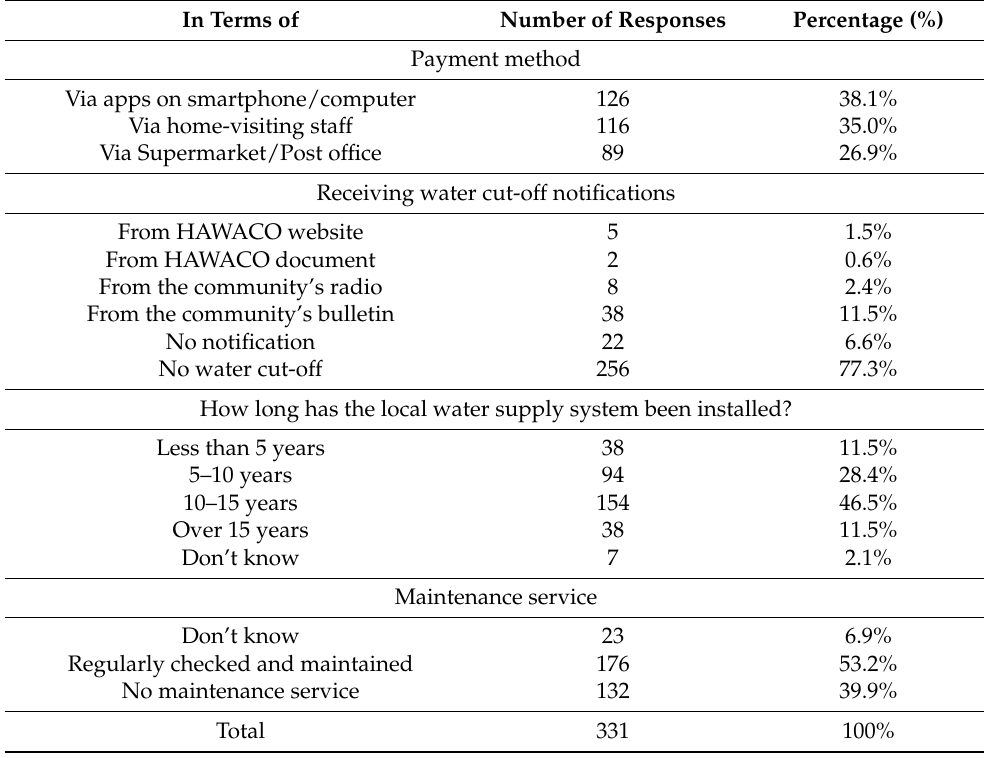
Table 5. Household responses regarding domestic water management and